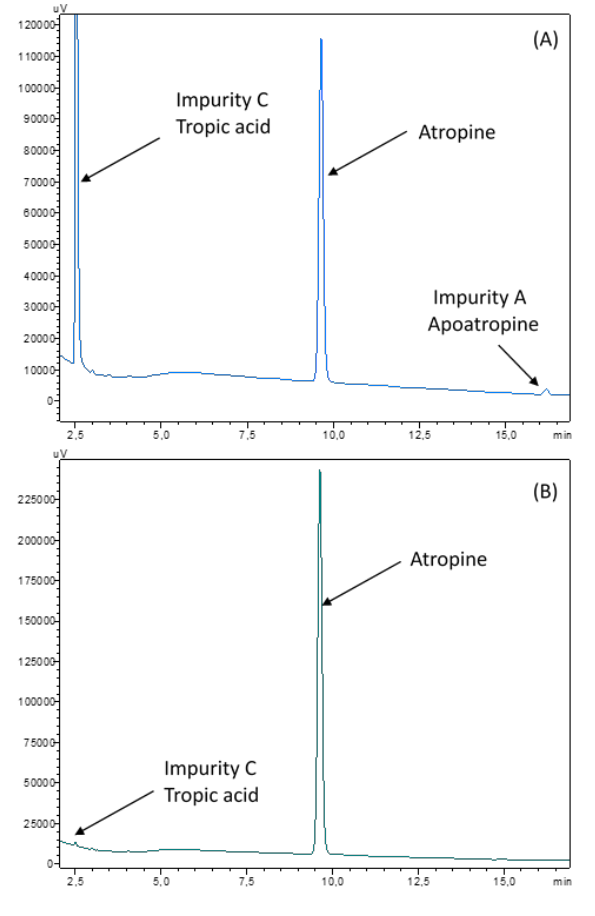
Figure 3. Chromatograms at 210 nm of breakdown products (BPs) obtained after forced degradation: ( A ) alkaline conditions of NaOH 0.5 N for 0.5 h and ( B ) acid conditions of HCl 0.1 N for 1 h at 90 °C. Detailed results of tropic acid quantification are presented in Supplementary data.